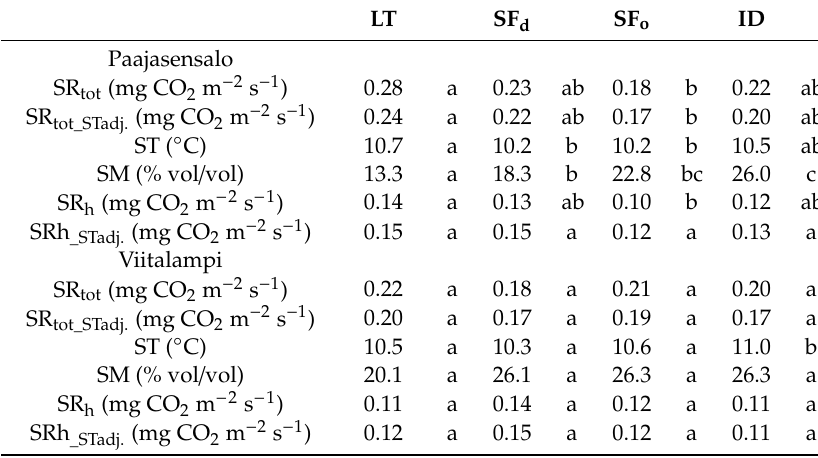
Table 2. Treatment mean total soil surface respiration (SR tot ) and soil-temperature-adjusted soil surface total respiration values (SR tot_ST adj. ), soil temperature (ST) and soil moisture (SM; non-trenched collars 2015–2017 data only), and heterotrophic soil respiration (SR h ) and soil-temperature-adjusted heterotrophic soil respiration (SR tot_STadj ; 2017 data from trenched collars only) for the Paajasensalo and Viitalampi study sites. Values are linear mixed-e ff ects model adjusted means. Treatment means followed by the same subscript letter are not significantly di ff erent ( p = 0.05; Sche ff e’s post hoc tests). LT = living trees, SF d = storm damaged, tree detritus, SF o = storm damaged, open-vegetated, ID = trees killed by I.